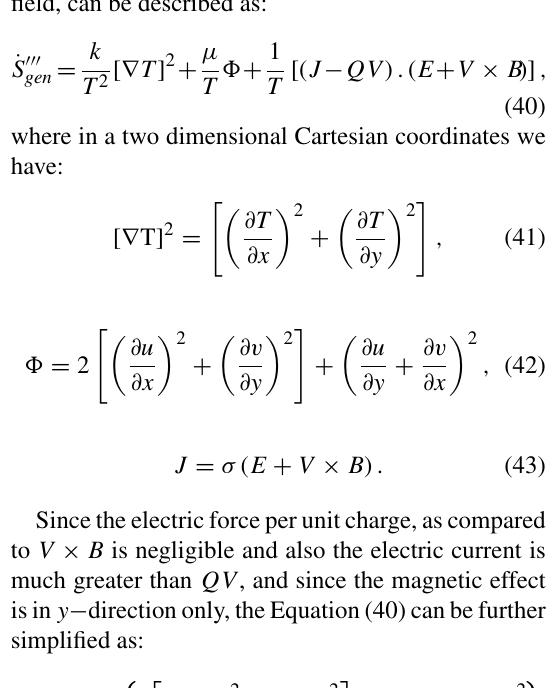
Fig. 8. Comparison of U ( y ) obtained by various orders of the HAM with numerical solution, when Re = 1 . 0 and Ha = 1 . 0 , [45].